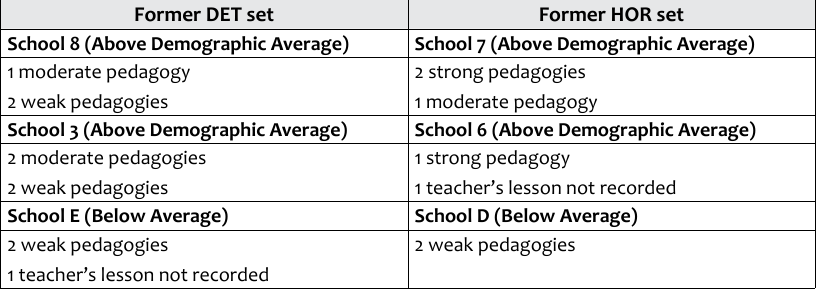
Table 3: Coding of pedagogies for HOR and DET set Former DET